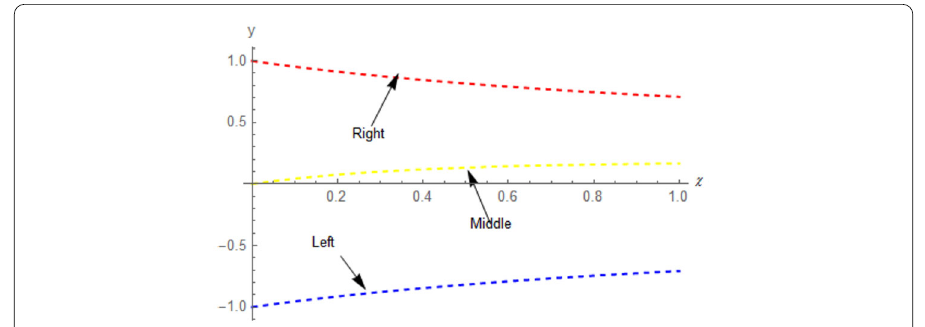
Figure 2 The graphs illustrate the result of the double inequality given by (2.15) for the case φ = 0, ϕ = 1, and k =